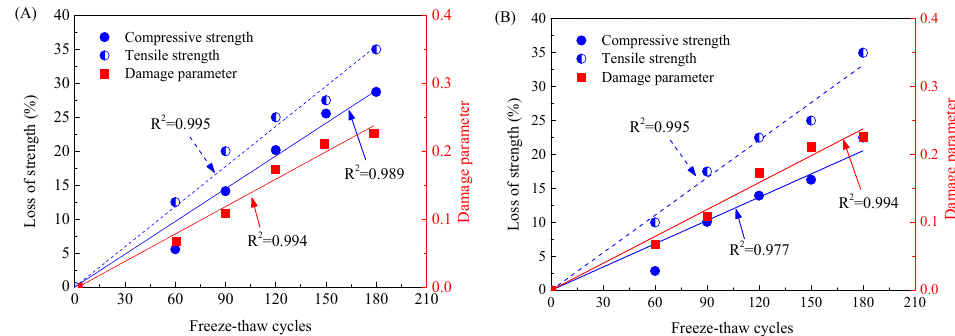
Figure 9. The relationship between strength loss and damage parameter for water-exposed ( A ) and sulfate-exposed ( B ) RAC.